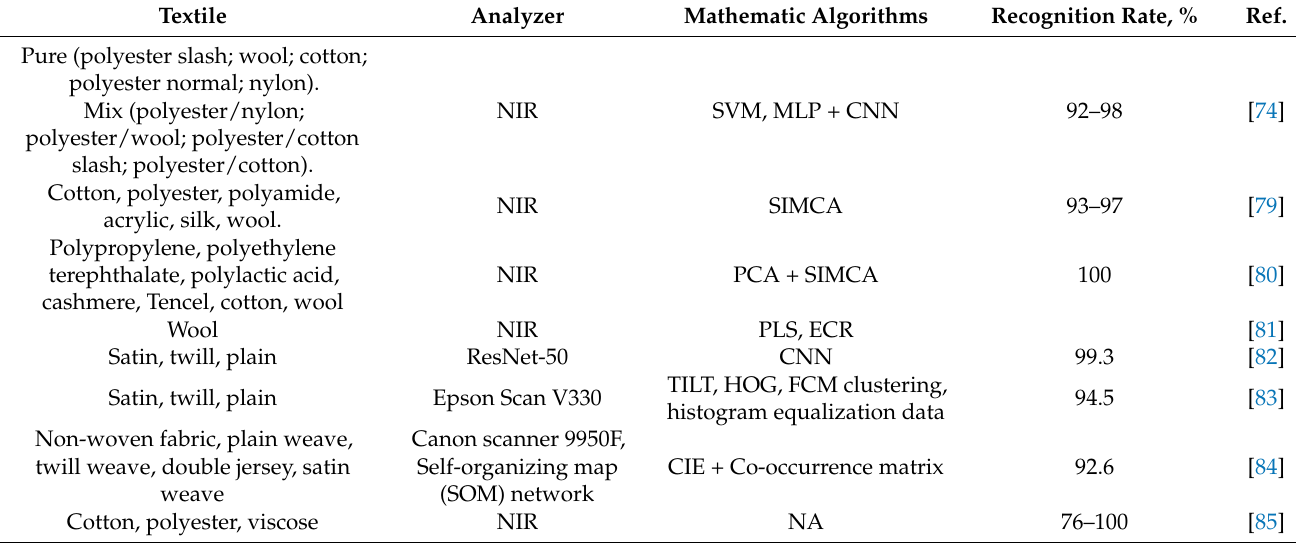
Table 1. The recognition rate with different types of analyzers. Textile Analyzer Mathematic Algorithms Recognition Rate,